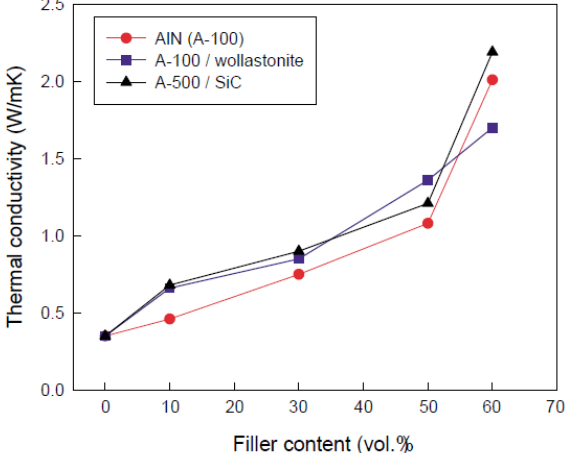
Figure 6. Thermal conductivity of composites containing hybrid filler (adapted from